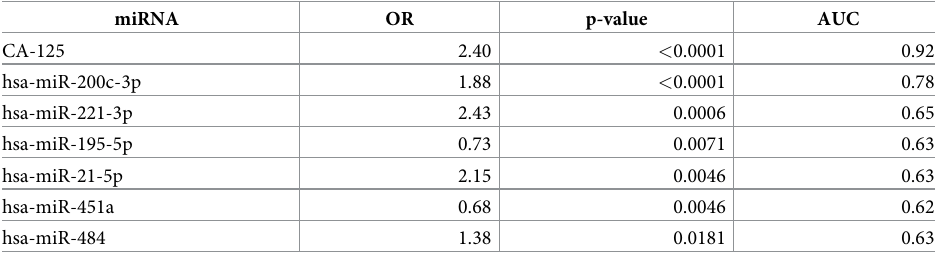
Table 2. Candidate miRNAs found on the ovarian cancer discovery cohort. miRNA OR p-value AUC CA-125 2.40 < 0.0001 0.92 hsa-miR-200c-3p 1.88 < 0.0001 0.78 hsa-miR-221-3p 2.43 0.0006 0.65 hsa-miR-195-5p 0.73 0.0071 0.63 hsa-miR-21-5p 2.15 0.0046 0.63 hsa-miR-451a 0.68 0.0046 0.62 hsa-miR-484 1.38 0.0181 0.63 OR: odds ratio. AUC: area under the curve. All p-values < 0.05 were considered as statistically